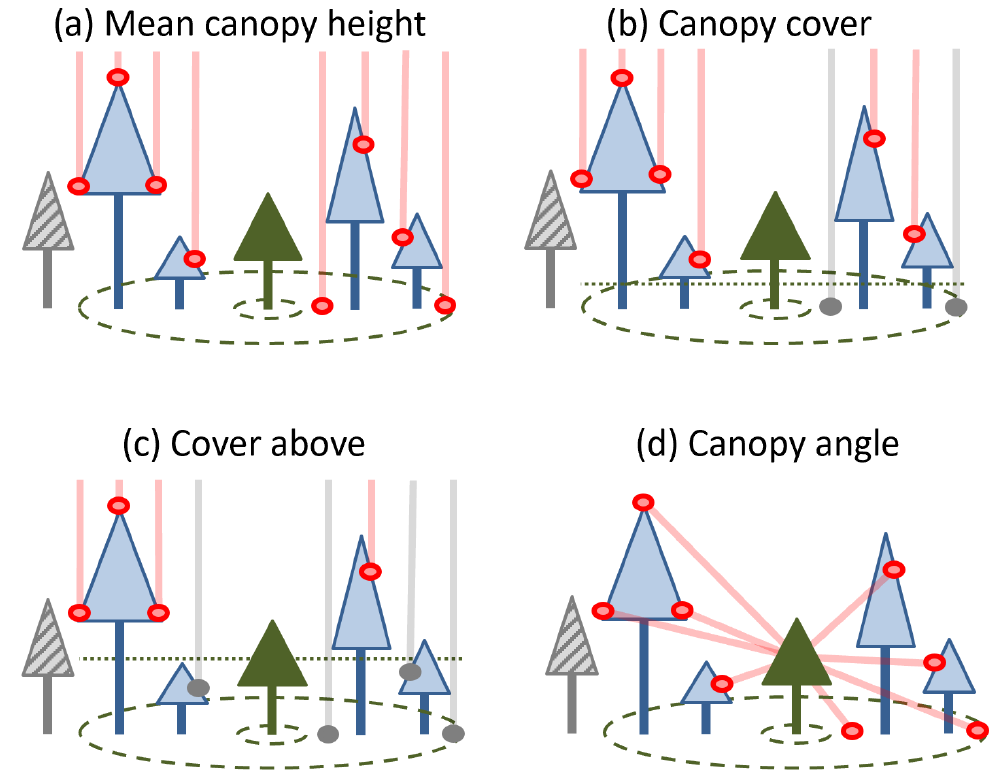
Figure 3. Schematic illustrations for the four neighborhood crowding indices used in this study adapted from [14]. In each panel, a focal tree (solid green) is subject to competition from neighbours (blue outlined trees) present in a given area (green dashed circles). Neighbours that are outside of this area or do not meet particular criteria (grey hashed trees) are not included in calculations. Indices are derived from the height above ground of cells outside of the subject tree’s crown that meet particular criteria (pink vs. grey circles and